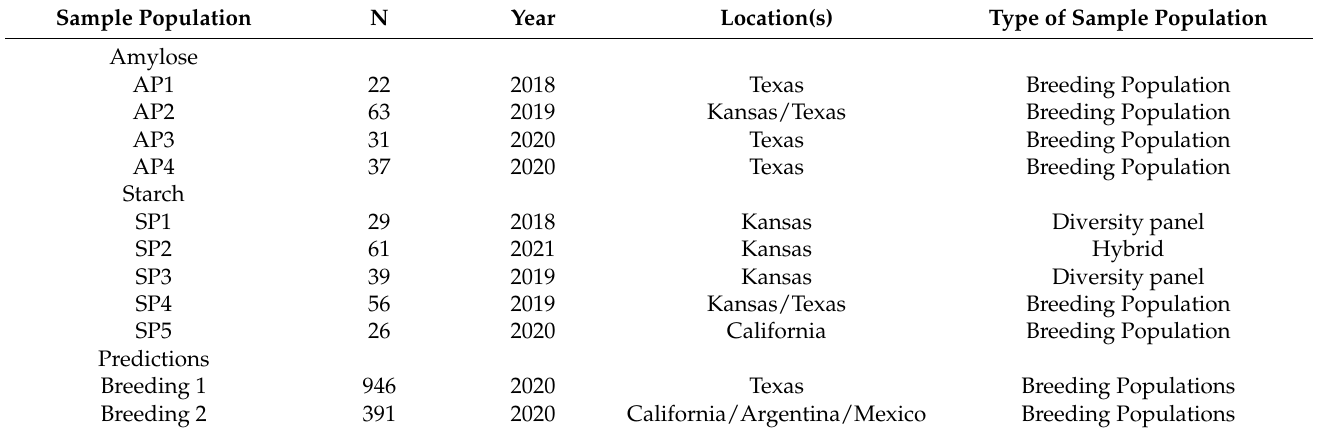
Table 1. Description of the sorghum grain sample population used in the